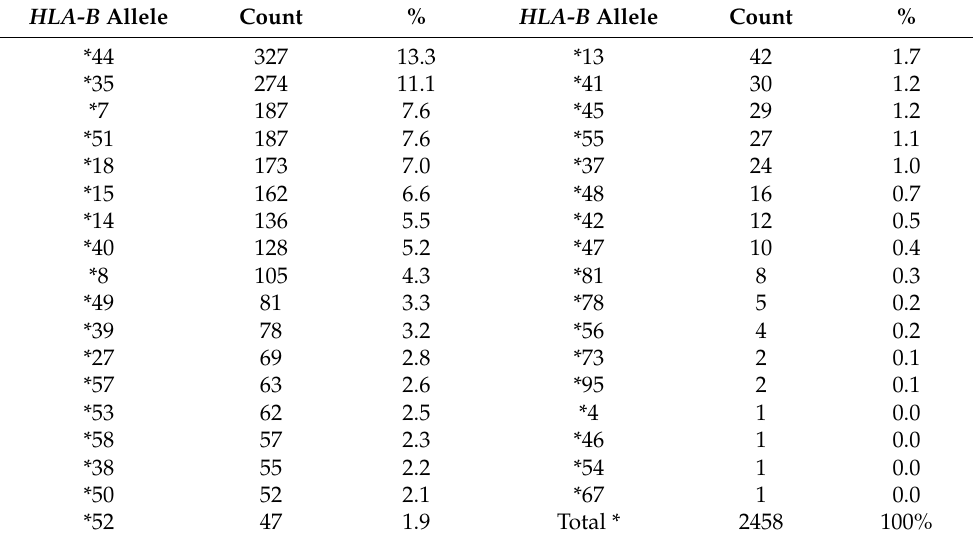
Table 3. Prevalence of HLA-B alleles in a Spanish